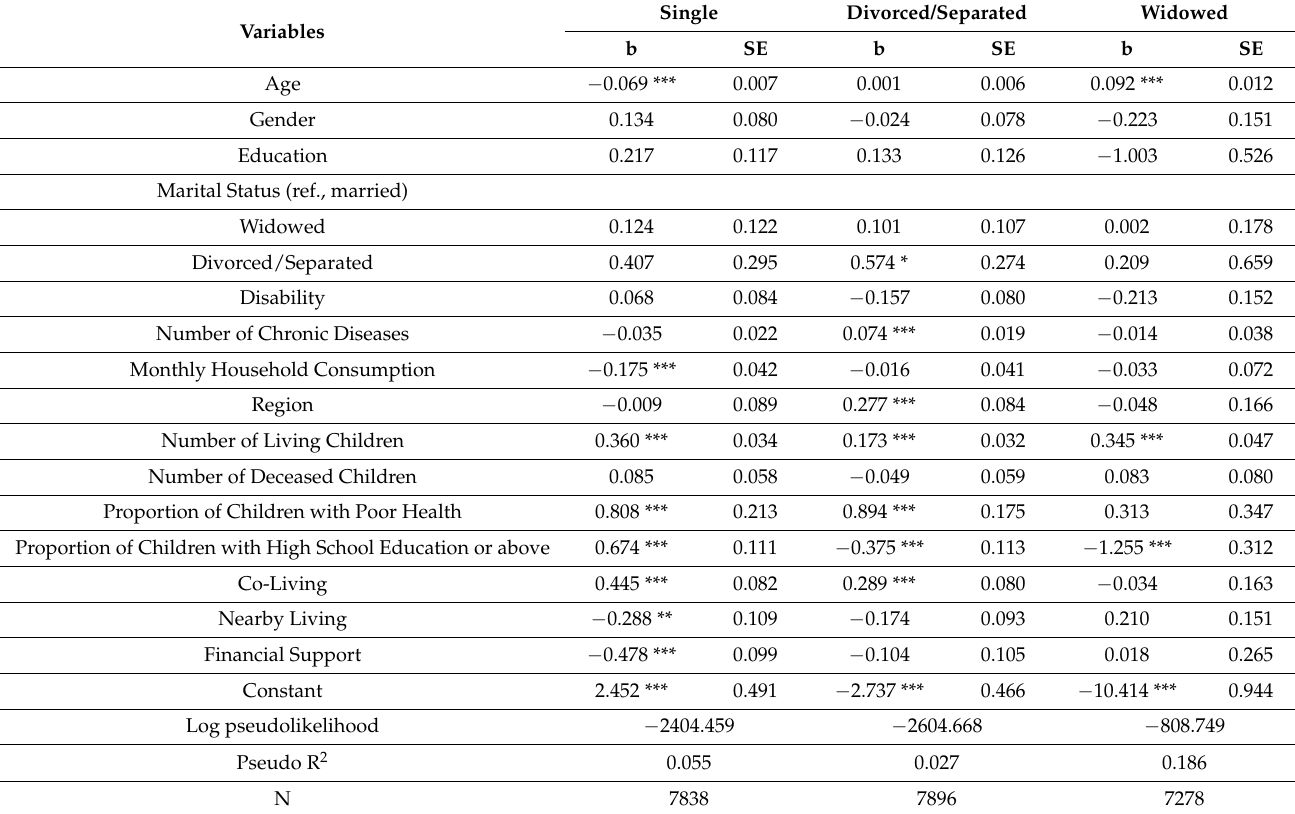
Table A3. The estimation results of logit model for children’s marital statuses.